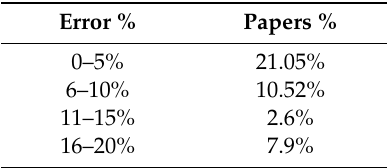
Table 9. Error % of experimental vs simulation